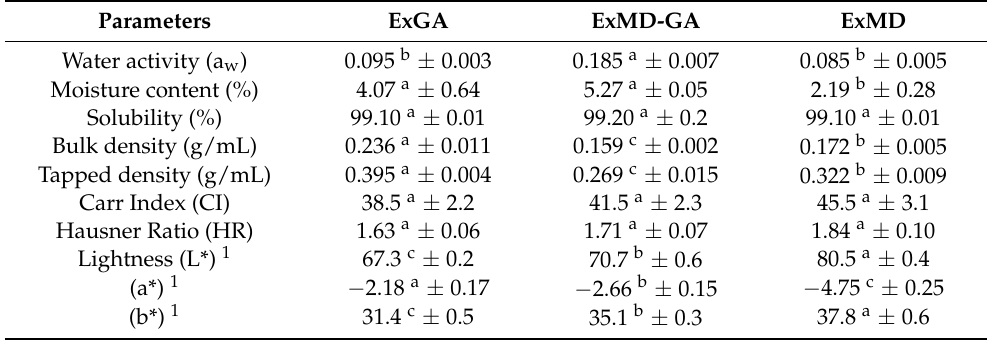
Table 2. Physico-chemical, colouring, antioxidant properties and composition of the differently microencapsulated hop